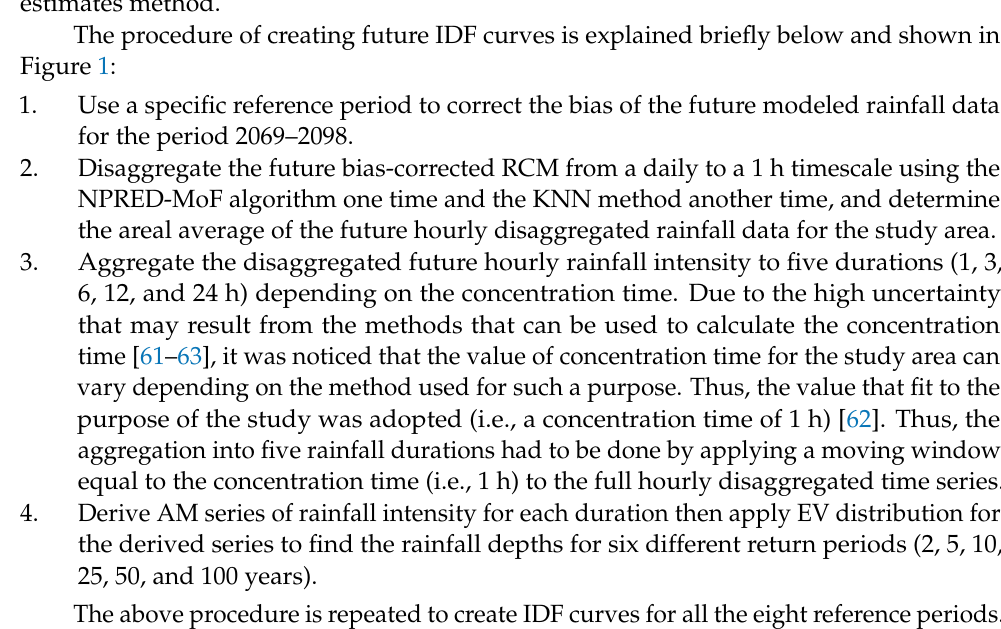
1. Use a specific reference period to correct the bias of the future modeled rainfall data for the period 2069–2098. 2. Disaggregate the future bias-corrected RCM from a daily to a 1 h timescale using the NPRED-MoF algorithm one time and the KNN method another time, and determine the areal average of the future hourly disaggregated rainfall data for the study area. 3. Aggregate the disaggregated future hourly rainfall intensity to five durations (1, 3, 6, 12, and 24 h) depending on the concentration time. Due to the high uncertainty that may result from the methods that can be used to calculate the concentration time [61–63], it was noticed that the value of concentration time for the study area can vary depending on the method used for such a purpose. Thus, the value that fit to the purpose of the study was adopted (i.e., a concentration time of 1 h) [62]. Thus, the aggregation into five rainfall durations had to be done by applying a moving window equal to the concentration time (i.e., 1 h) to the full hourly disaggregated time series. 4. Derive AM series of rainfall intensity for each duration then apply EV distribution for the derived series to find the rainfall depths for six different return periods (2, 5, 10, 25, 50, and 100 years). The above procedure is repeated to create IDF curves for all the eight reference